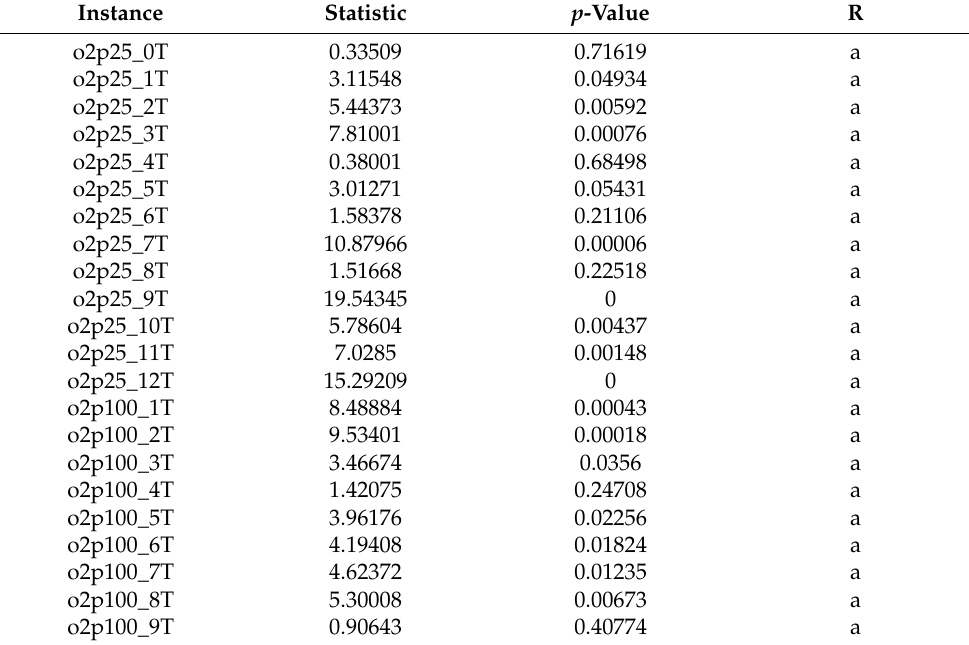
Table 9. Generalized Spread homoscedasticy test, the null hypothesis is that all the input populations come from populations with equal variances, which is accepted (a) when p -value < 0.05 and rejected (r) otherwise. Observe that the null hypothesis is accepted (a) for all the instances. The parametric t student test can be applied for all the instances that accept the null hypothesis in the normality tests. Instance Statistic p -Value R o2p25_0T